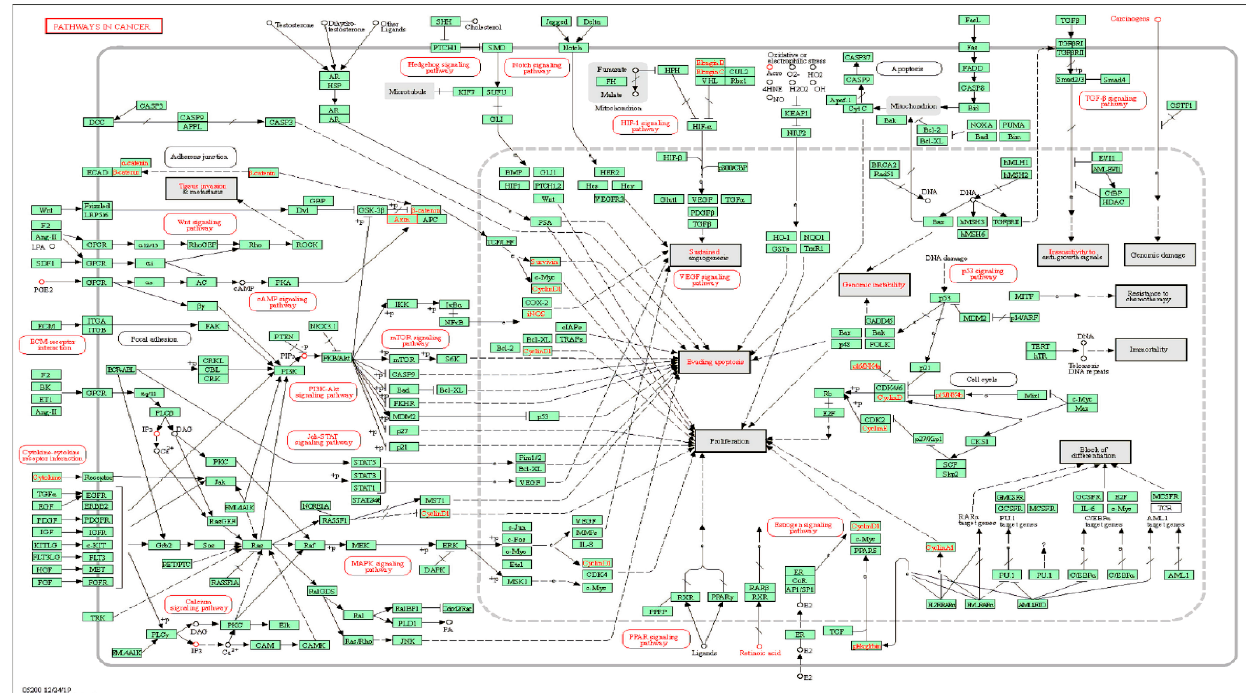
Figure 4. A map showing ‘cancer’-related pathways.